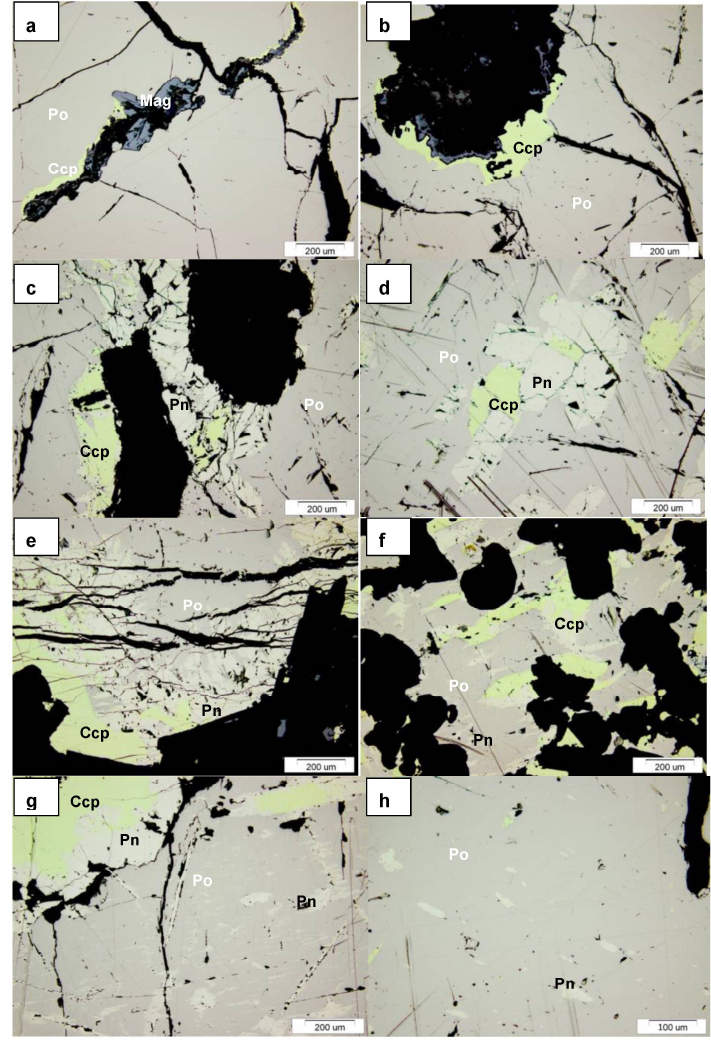
Figure 9. Photomicrographs of the ore from North-Eastern branch of the Talnakh intrusiona-f—borehole SF-10, depth, m: ( a , b )—726; ( c , d )—817; ( e , f )—818; ( g , h )—borehole OUG-2, depth 1211 m. Here and in Figure 12: Po—pyrrhotite, Pn—pentlandite, Ccp—Chalcopyrite, Mag—magnetite.